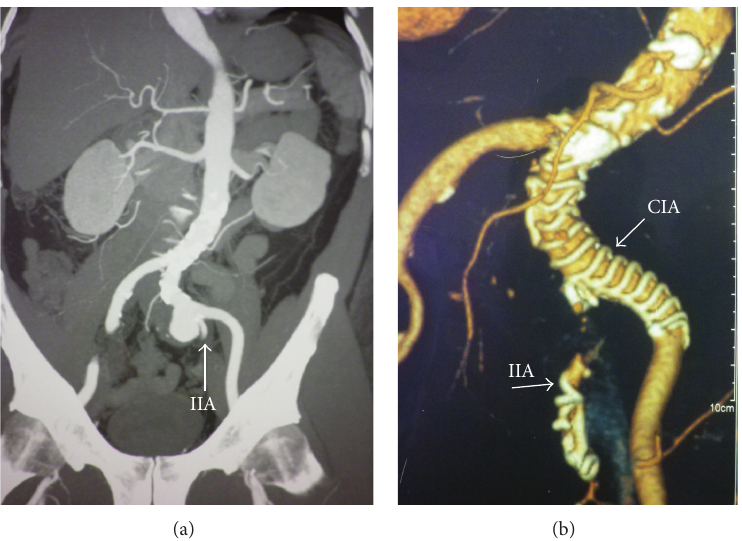
Figure 2: (a) A 60-year-old male patient with LCIA aneurysm with diameter 3.5 × 3.6 cm, length 3.8 cm, and severe angulation of the iliac axis extended to the orifice of the IIA. (b) Two years postoperatively, the aneurysm sac is thrombosed. Notice the coils into the